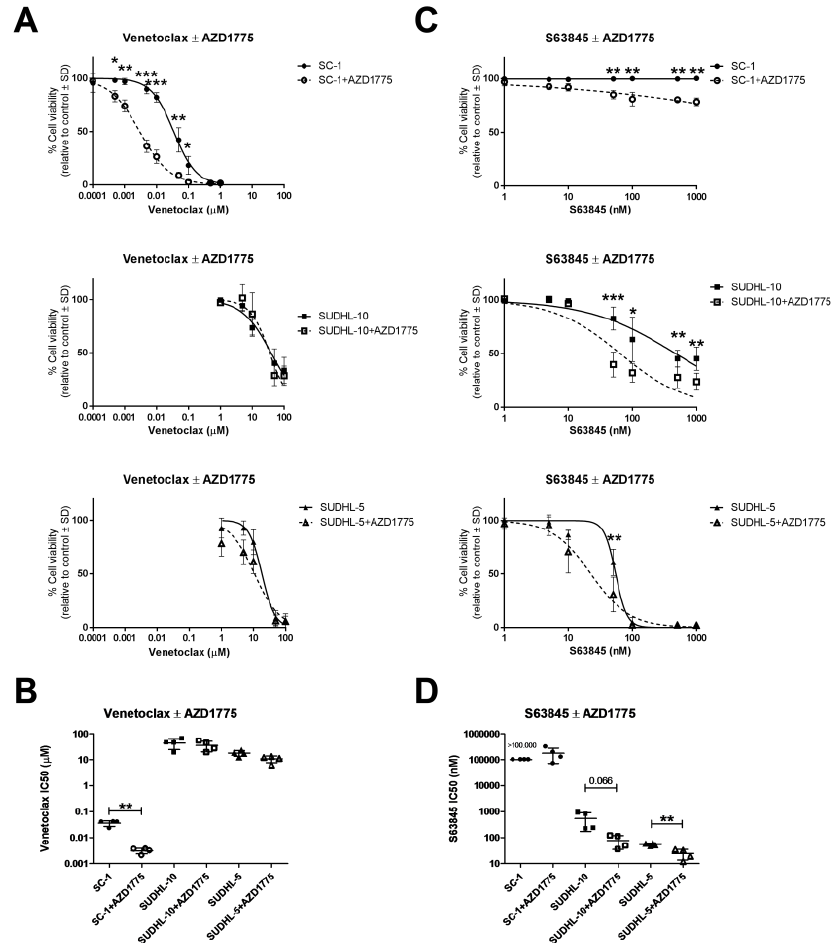
Figure 4. Combination of AZD1775 and BH3 mimetic drugs in DLBCL cell lines. ( A ) Cell viability flow cytometry data for the cell lines SC-1, SUDHL-5, and SUDHL-10 pre-treated with 1 µ M AZD1775 and incubated with increasing concentrations of venetoclax. Data were normalized to the control and plotted as the mean ± SD ( n = 4). ( B ) Venetoclax IC50 values as calculated from cell viability curves. Data were plotted as the mean ± SD ( n = 4). ( C ) Cell viability flow cytometry data for SC-1, SUDHL-5, and SUDHL-10 pre-treated with 1 µ M AZD1775 and incubated with increasing concentrations of S63845. Data were normalized to the control and plotted as the mean ± SD ( n = 4). ( D ) S63845 IC50 values as calculated from cell viability curves. Data plotted as the mean ± SD ( n = 4). Statistical analysis was performed using a two-tailed paired t -test (* p ≤ 0.05) (** p ≤